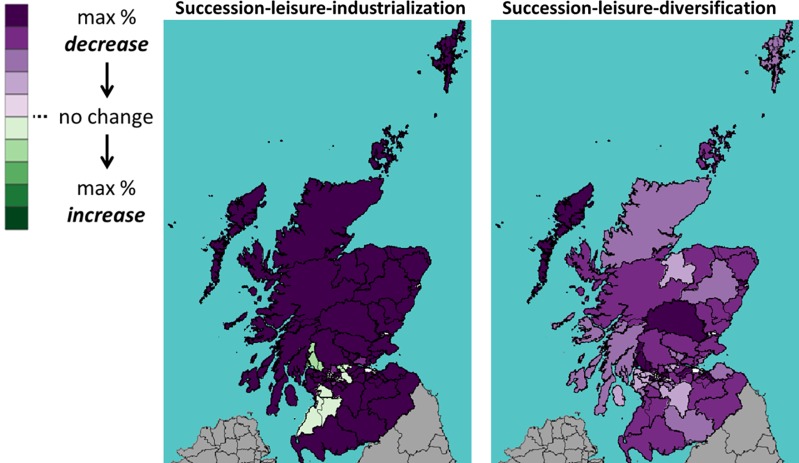
Percentage change in the number of beef cattle under UTL scenario.